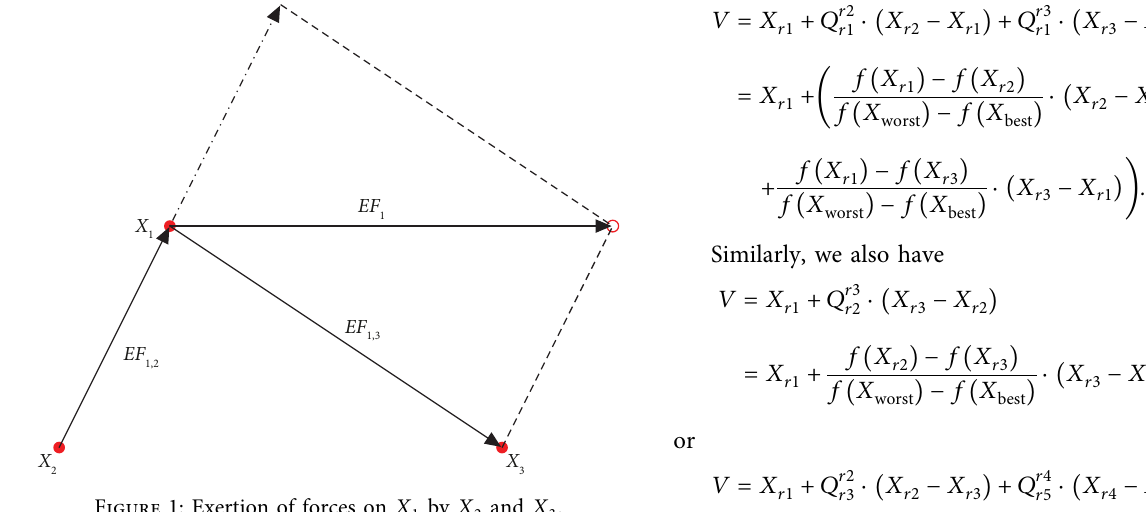
by X and X 1 2 3